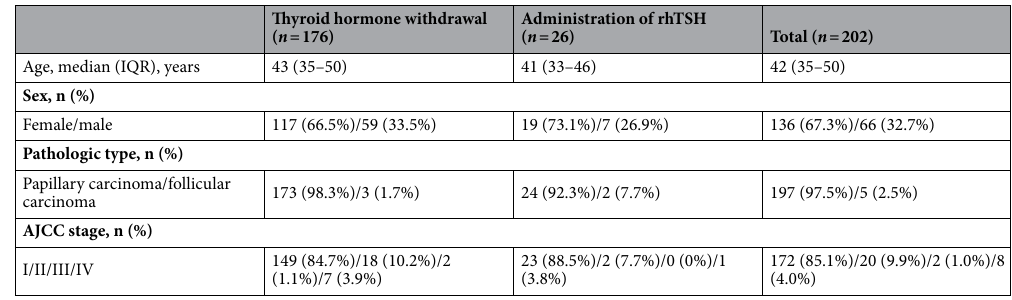
Table 1. Patient characteristics. rhTSH recombinant human thyroid-stimulating hormone, IQR interquartile range, AJCC American Joint Committee on Cancer.